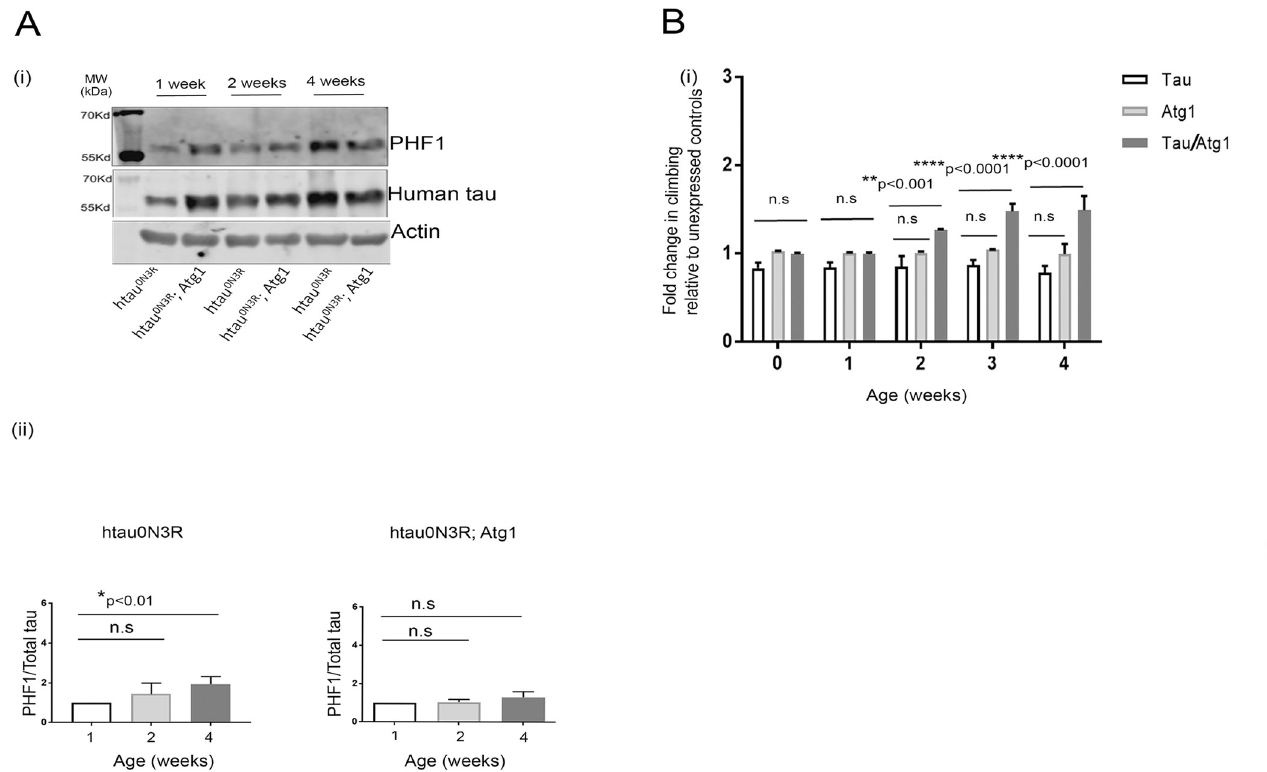
Fig 5. Upregulation of autophagy decreases the age-related accumulation of hyperphosphorylated tau and ameliorates tau-induced locomotor defects in human Tau (0N3R) expressing transgenic flies. Pan-neuronal expression of human 0N3R tau significantly increases the age-dependent accumulation of hyperphosphorylated tau that is restricted by coexpression of autophagy marker Atg1. Representative western blot images for PHF1, total tau and Actin (A i) and quantification of PHF1 relative to total tau normalized to Actin (A ii) in htau 0N3R and htau 0N3R /Atg1 overexpressing Drosophila models respectively. � p < 0.01 by one-way ANOVA with Bonferroni’s correction. Data represent mean ± S.E.M. Expression of 03NR human tau pan-neuronally in adult flies induces locomotor deficits that are rescued by coexpression of Atg1 (B) Comparison of the climbing ability with age over a period of 4 weeks for hTau 0N3R , Atg1 and hTau 0N3R /Atg1 transgenics (n = 50). (2 way ANOVA; � p < 0.05, �� p < 0.001, ���� p < 0.0001). Error bars are plotted as ± S.E.M. Genotypes: hTau 0N3R = {w; Elav - Geneswitch/ UAS -htau 0N3R }, Atg1 = {w; Elav -Geneswitch/+; UAS -Atg1/+}, hTau 0N3R /Atg1 = {w; Elav -Geneswitch / UAS -htau 0N3R ; UAS -Atg1/+}, on an OreR background.